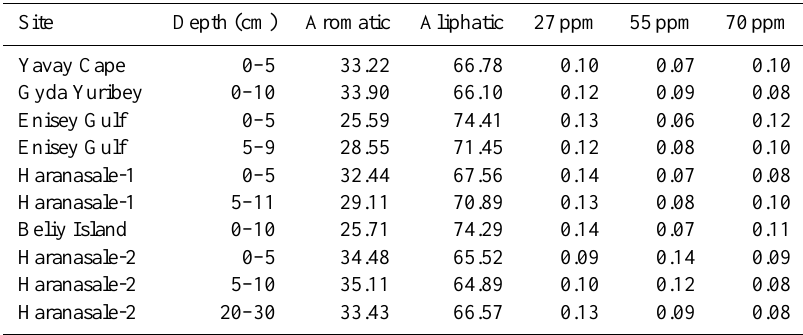
Table 4. Total aromatic and aliphatic carbons, and maximal signal intensity at the threeppm of maximum variability in the 13 C-NMR spectra. Data are expressed as percent of total carbon.